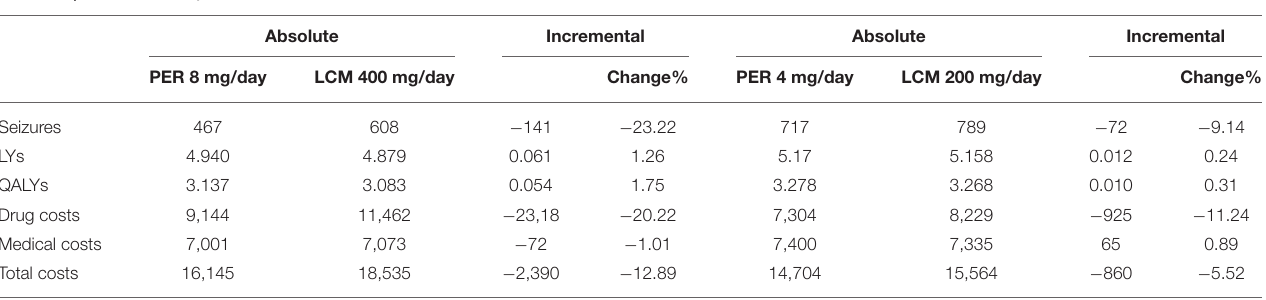
TABLE 6 | Base case analysis results.